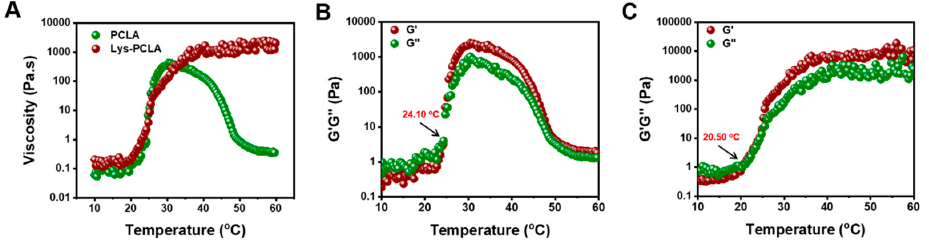
Figure 5. Mechanical properties of hydrogels. ( A ) Viscosity of hydrogels as a function of tempera- ture. Storage modulus (G’) and loss modulus (G ″ ) of ( B ) PCLA hydrogels and ( C ) Lys-PCLA hydro-